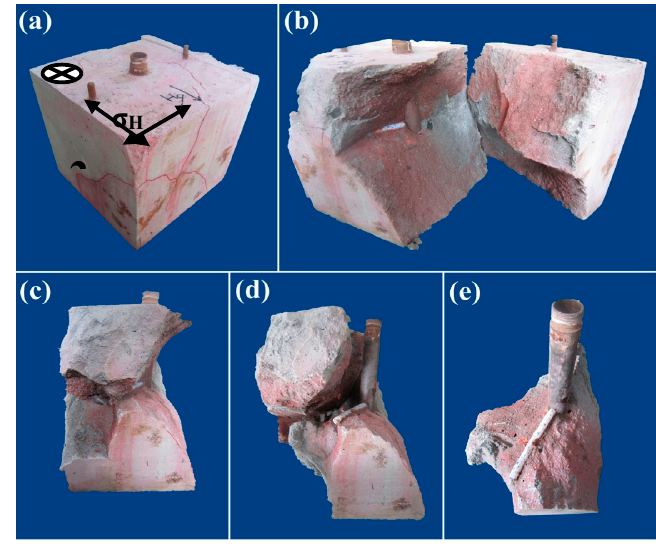
Figure 16. Fracture morphology after hydraulic fracturing of sample 2#: ( a ) the overall picture before opening; ( b ) the fracture initiates in the heel of radial borehole; ( c – e ) the multi-branch fractures occur in the core.